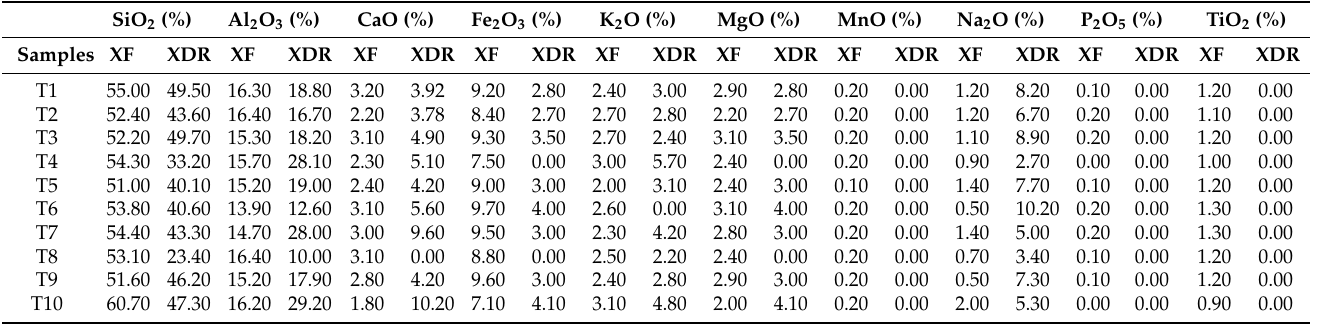
Table 5. Mineral elements of soil samples determined by ED-XRF fluorescence and X-ray